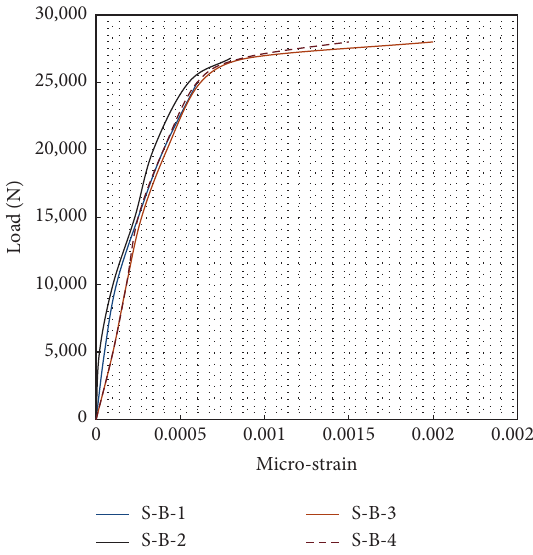
Figure 10: Load-rosettes strain for group